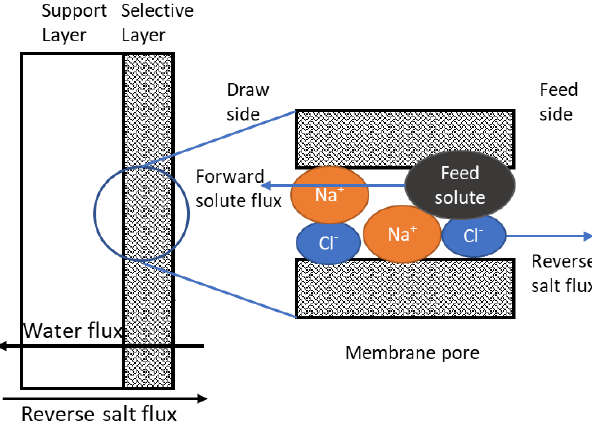
Figure 3 . Schematic of the reverse flux of the draw solutes retarding forward diffusion of feed solutes in the FO process; after Xie et al. [65].